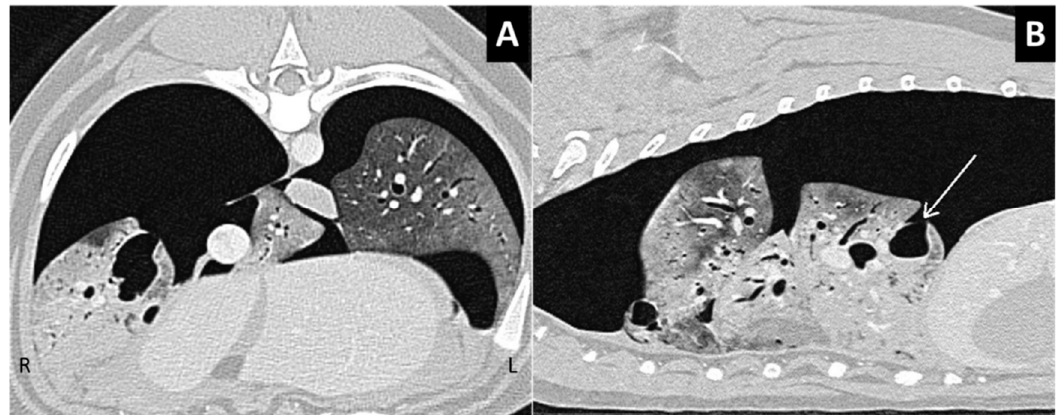
Figure 8. ( A , B ) Transverse and right-parasagittal views of the thorax in a patient with subpleural lung laceration and massive pneumothorax, with subsequent lung collapse.